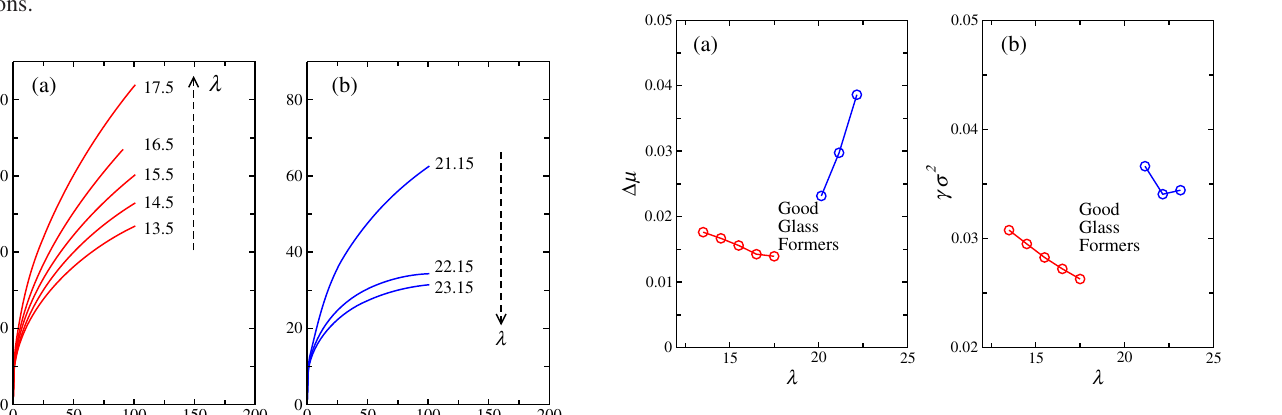
FIG. 8. (a) Chemical potential difference ( Δ μ ) along T=T 0 . 8 . (b) Interface free energy ( γ ) for the same points as in